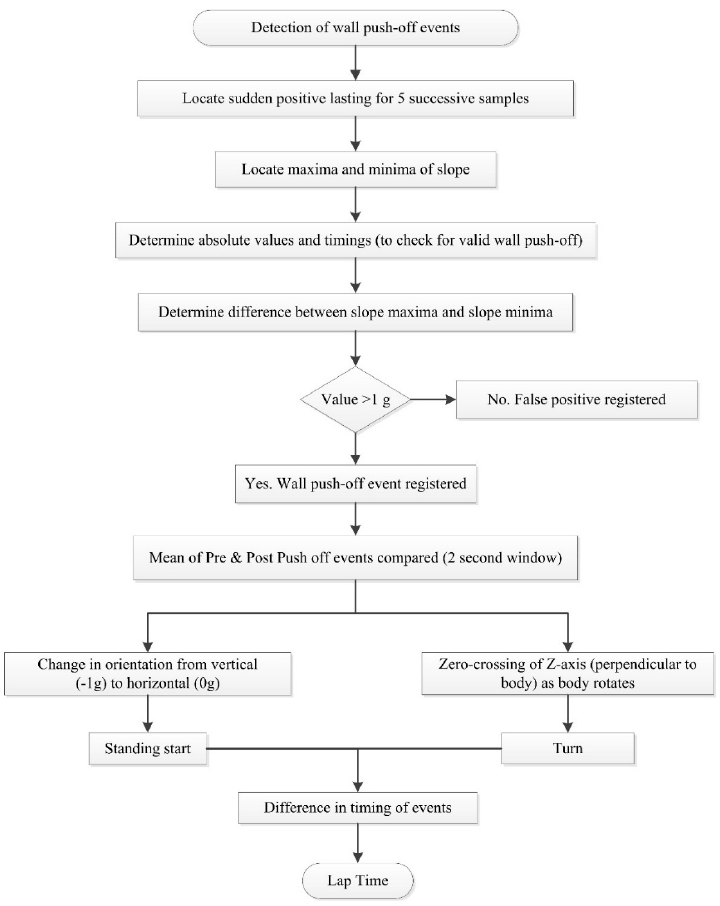
Figure 14. Flowchart for a lap time detection algorithm based on detection of wall push-off events. Adapted from Davey, Anderson and James [11].